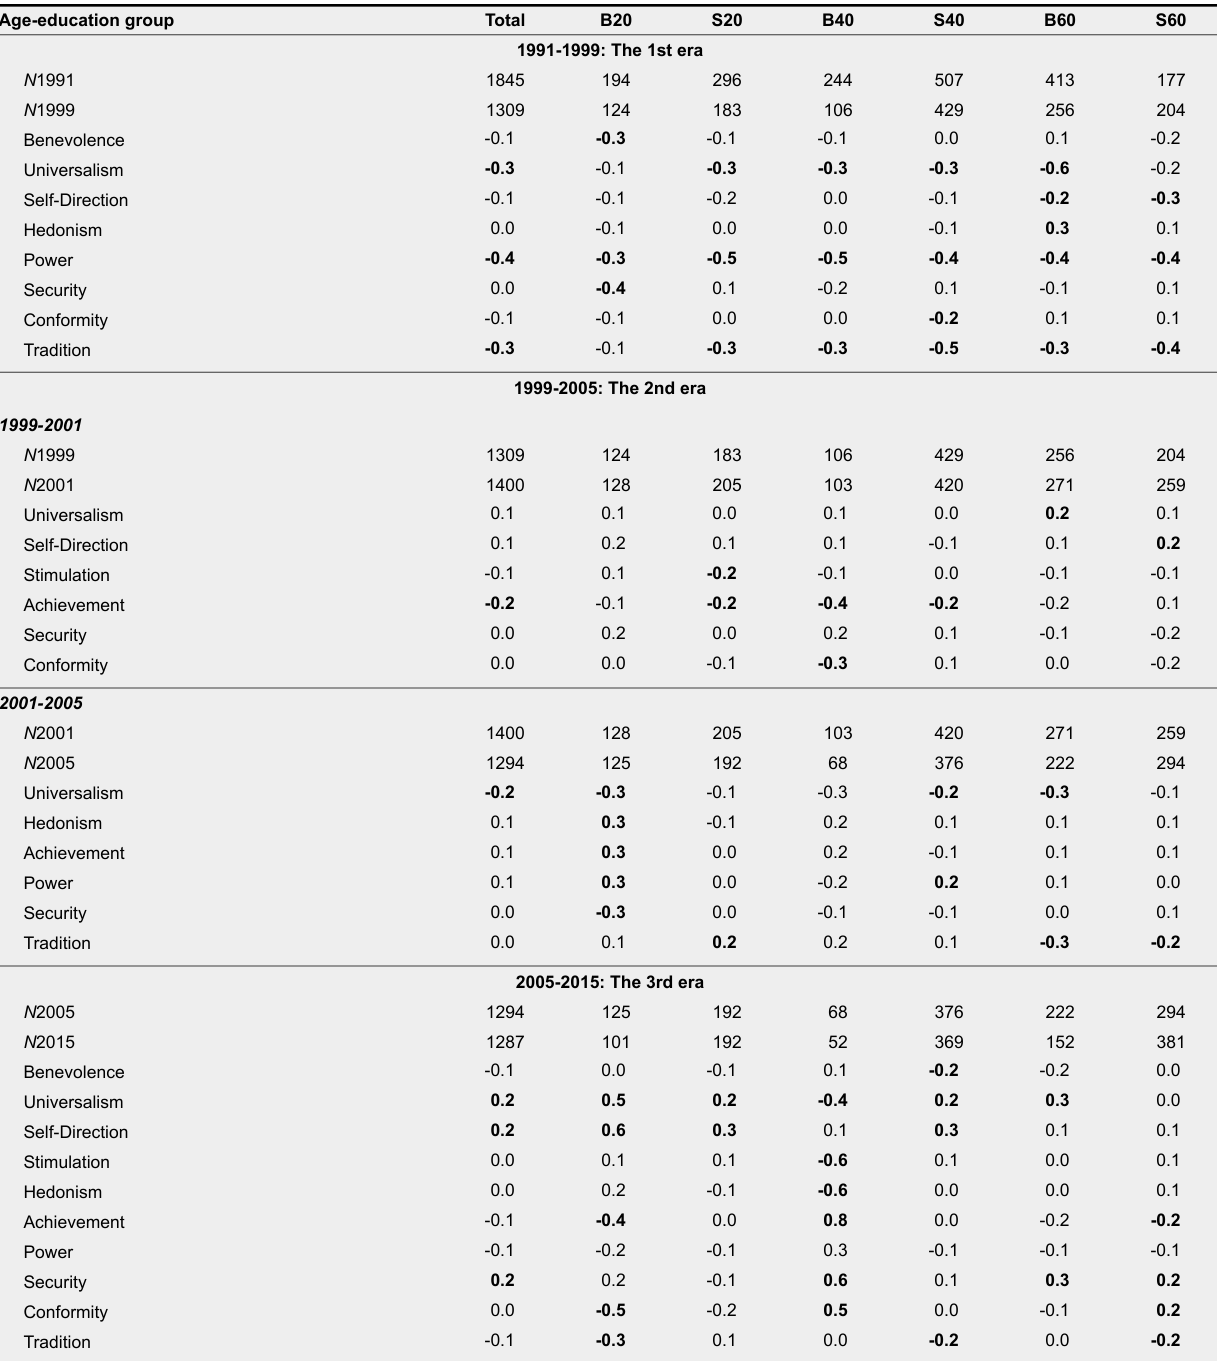
Note. Values for each time span are ordered from Growth (top) to Protection (bottom). The results of each ANOVA are condensed into one figure, Cohen’s d . For value changes that met the DS criterion ( p < .05 and d ≤ -0.2 or d ≥ 0.2), d s are printed in underlined bold to indicate an increase, and in mere bold to indicate a decrease. The definitions of the six groups: B = basic education or less, and S = secondary edu- cation or more; 20: 15-29 yrs. 40: 30-49 yrs, and 60: 50-75